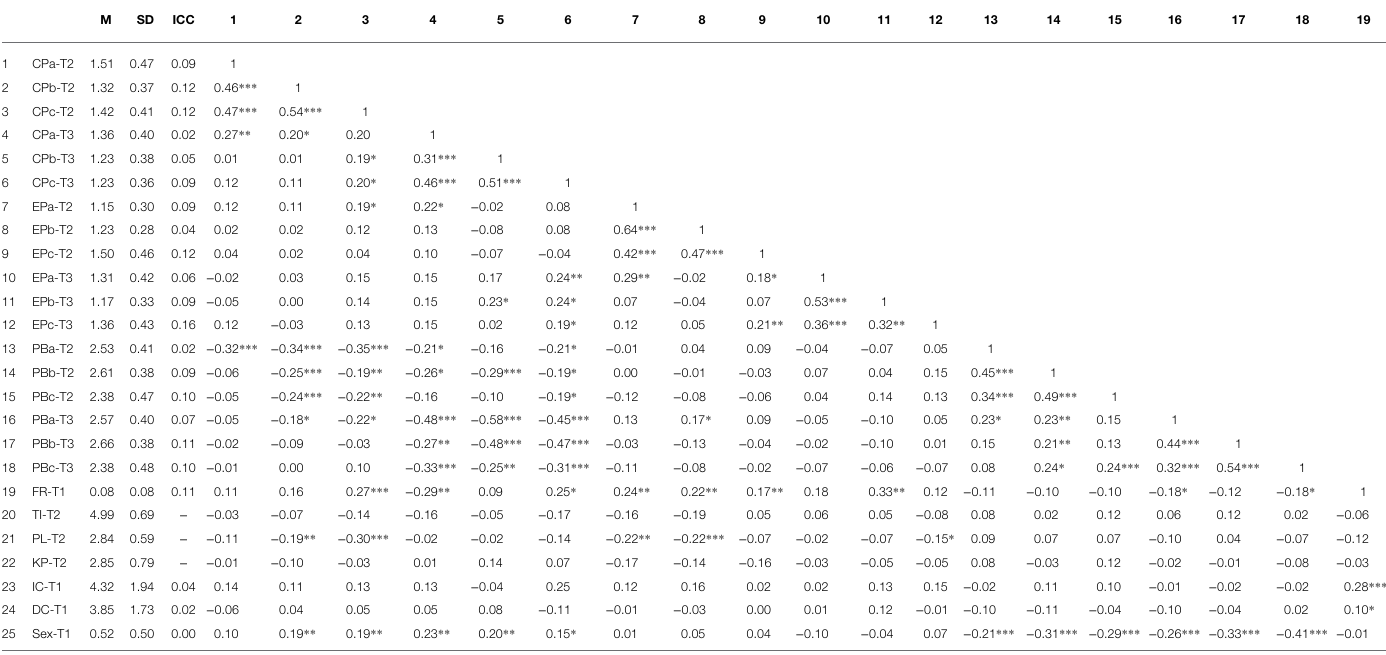
1 CPa-T2 1.51 0.47